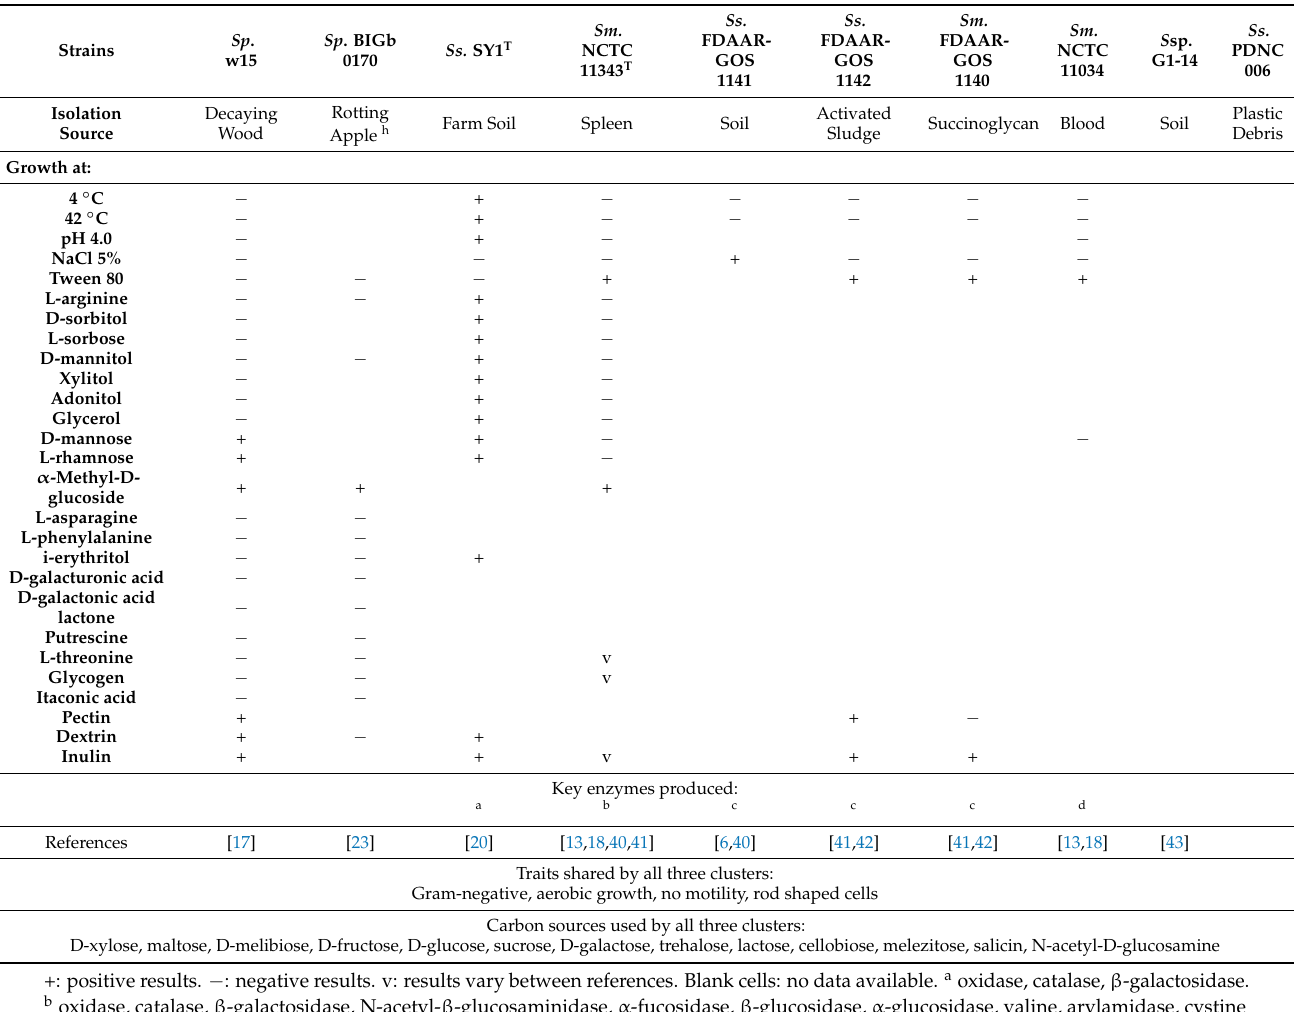
Table 6. Strain origins and ecophysiological data.